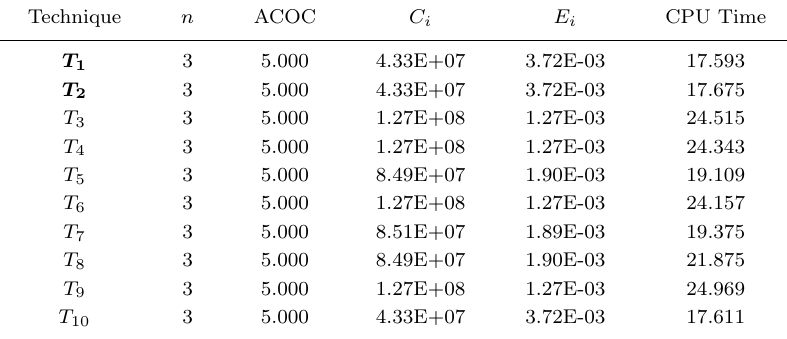
Table 6. Comparison of performance of techniques for Problem 5.